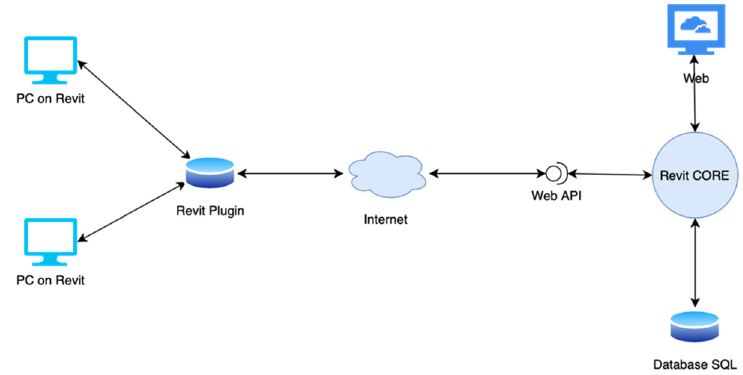
Figure 1. Computer architecture of the BIMLegacy project (redrawn from [45]).